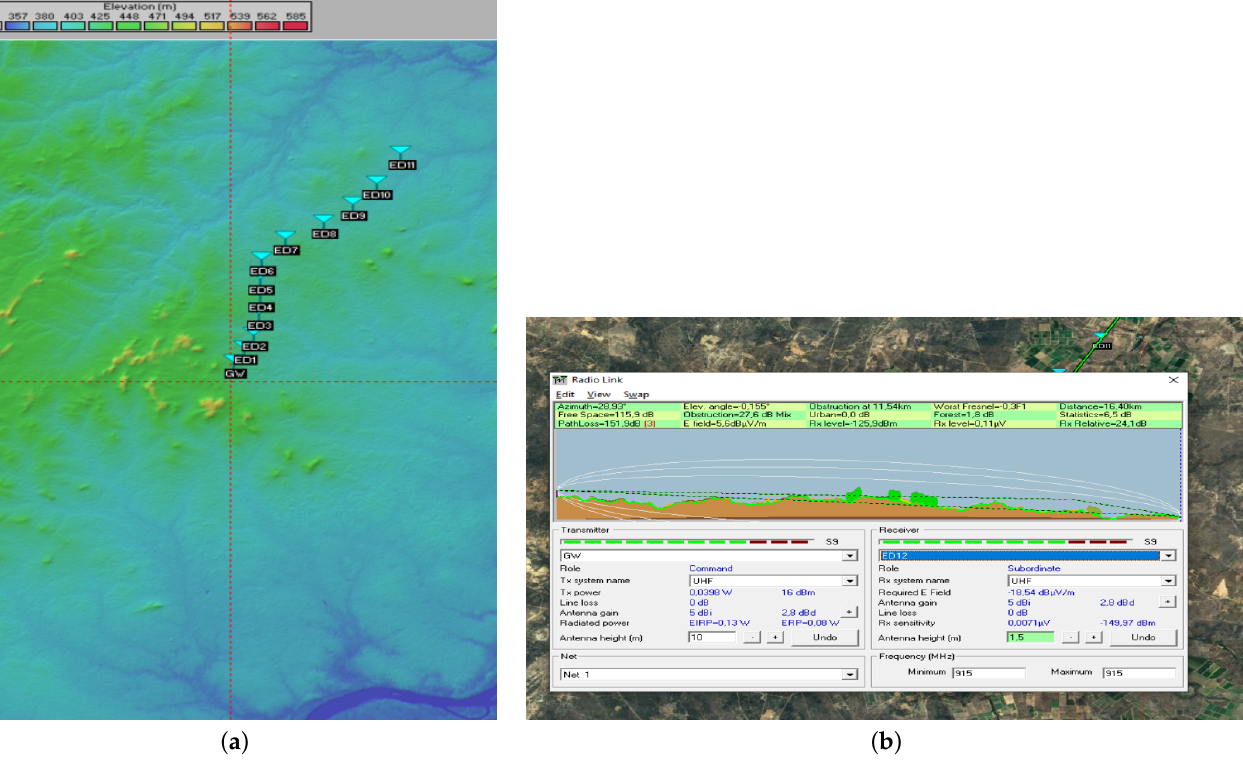
Figure 4. Screen capture of Radio Mobile software with ( a ) the EDs positions on the map, and ( b ) the link details of the most distant EDs.